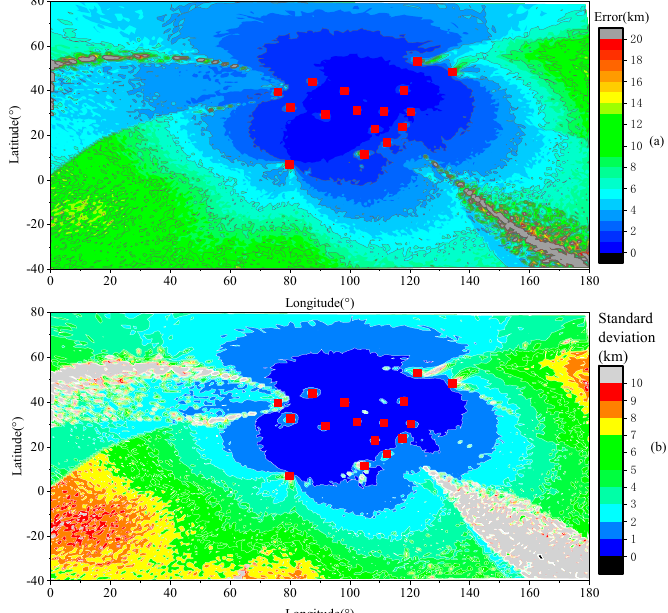
Figure 8. ( a ) Spatial distribution of the mean location error that calculated by the Monte Carlo simulation. ( b ) Spatial distribution of the standard deviation of the location error that calculated by the Monte Carlo simulation. Each red box represents a site.